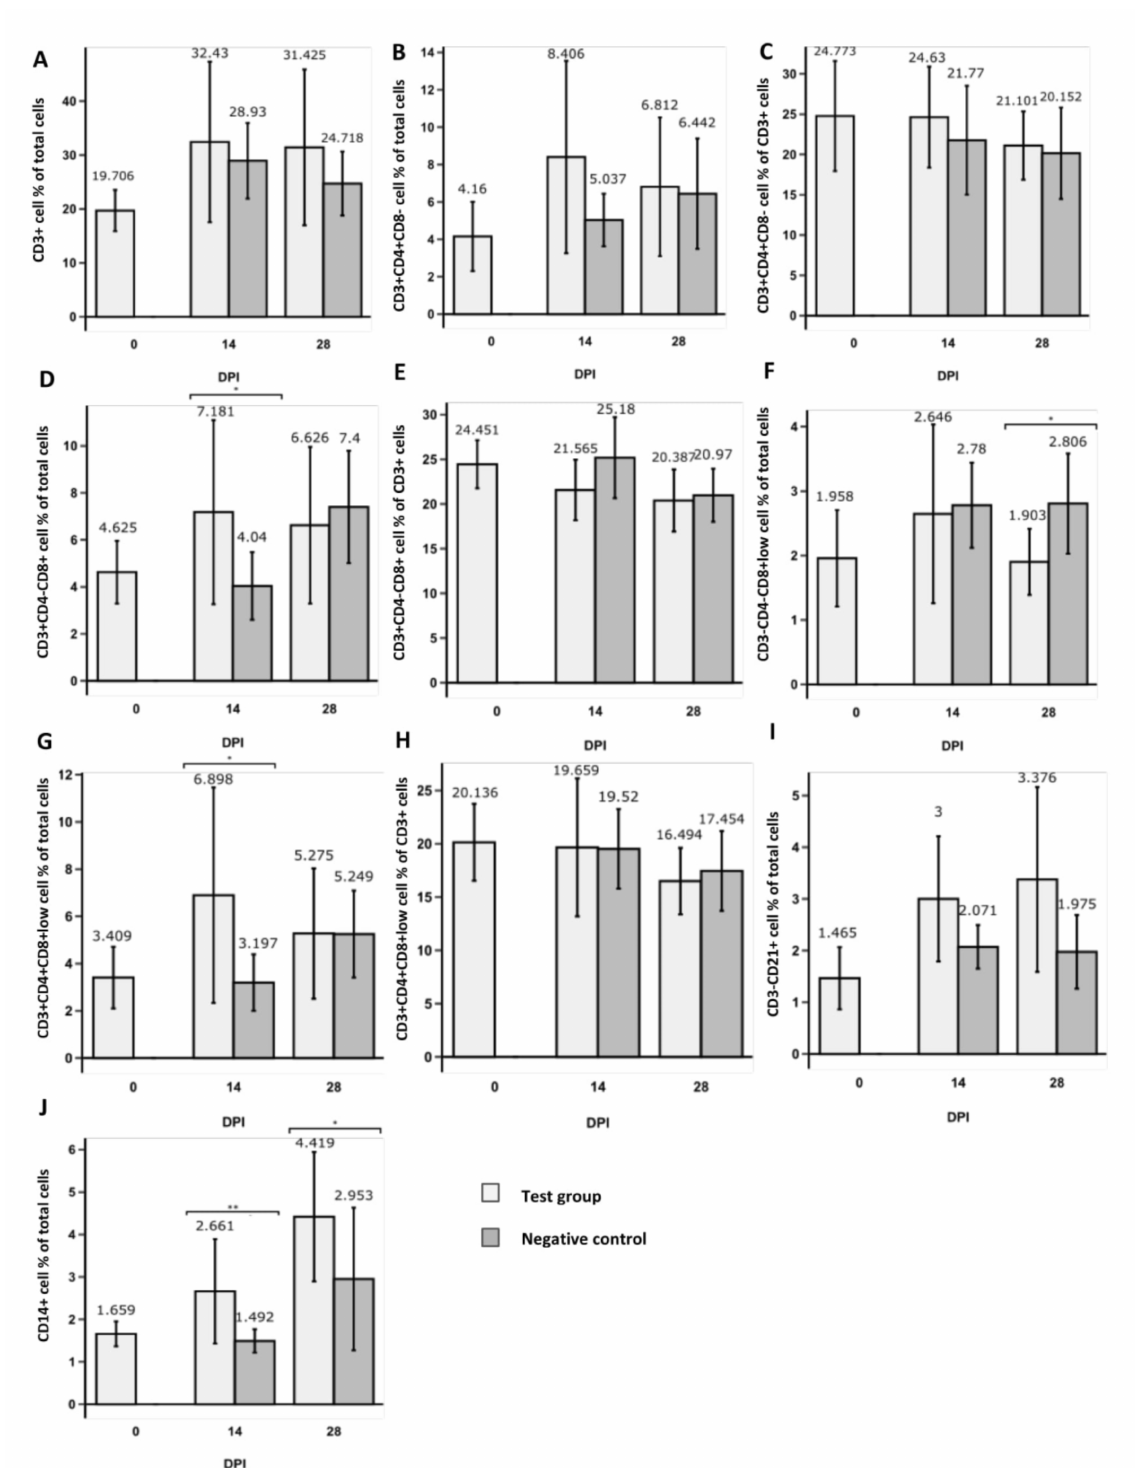
Figure 3. Comparison between immune cell subpopulations of test animal and negative control groups obtained from pigs before (0DPI), 14 days (14DPI) and 28 days (28DPI) after supplementary feeding by flow cytometry. Bar plots show the percentage (mean ± SD) of CD3 + cells ( A ), T helper cell (CD3 + CD4 + CD8 − ) proportion of total ( B ) and CD3 + ( C ) cells, T cytotoxic cell (CD3 + CD4 − CD8 + ) proportion of total ( D ) and CD3 + ( E ) cells, percentage of NK cells (CD3 − CD4 − CD8 +low ) ( F ), T memory cell (CD3 + CD4 + CD8 +low ) proportion of total ( G ) and CD3 + ( H ) cells, percentage of B cells (CD3 − CD21 + ) ( I ), and percentage of macrophage/monocyte cells (CD14 + ) ( J ). Asterisk indicates statistical significance between groups based on two-tailed Wilcoxon rank sum test results ( * p < 0.05; ** p <